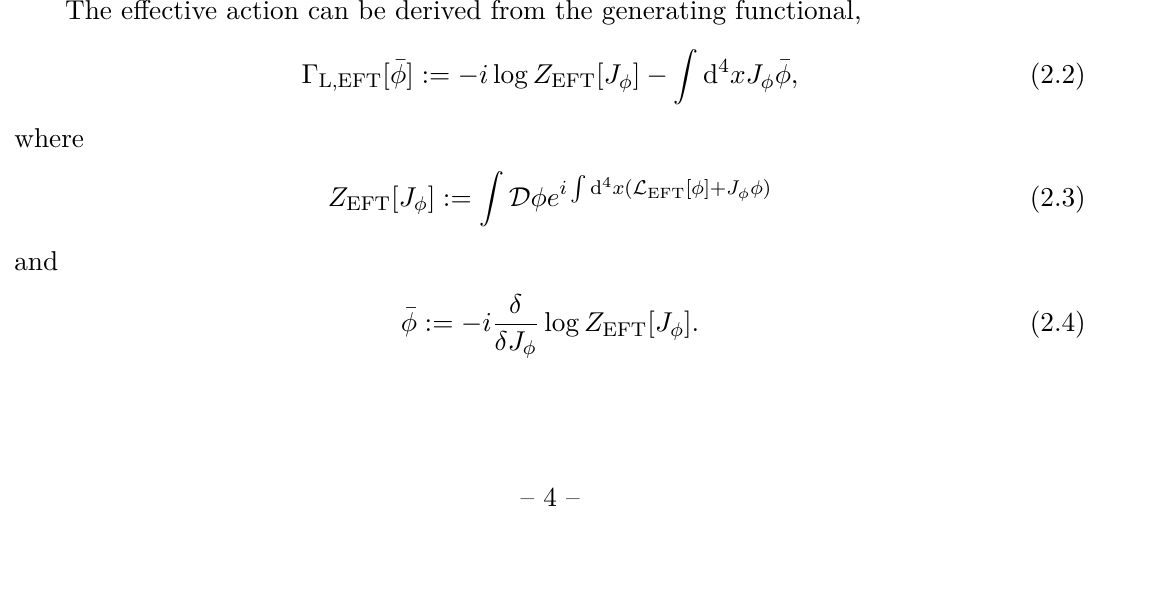
figure 1: we briefly review the functional method and the covariant derivative expansion technique in section 2, and also discuss how to translate the Green’s basis into the Warsaw basis after removing the redundancy from EOM. We then present our tree and one-loop matching results for all the three seesaw models in section 3. In section 4, we solve the com- plete one-loop running of the renormalization group equations (RGEs) using PyR@TE3 [59], addressing the difference of the three seesaw models in triggering electroweak symmetry breaking (EWSB). Phenomenological implications are then qualitatively discussed in sec- tion 5, with a special emphasis on operators listed in figure 1 due to their rich